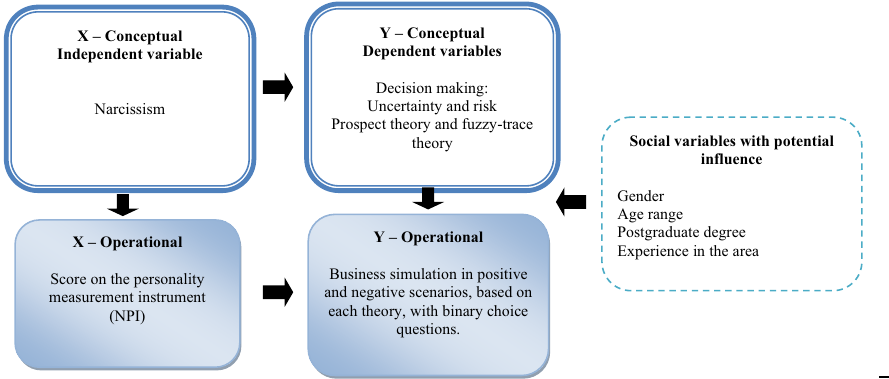
Figure 1. Narcissism